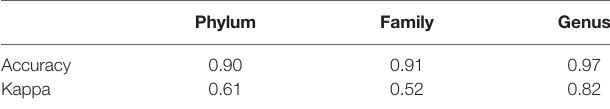
TABLE 4 | Evaluation of random forest model performance on classifying DD status from microbial composition at three taxonomic levels. Phylum Family Genus